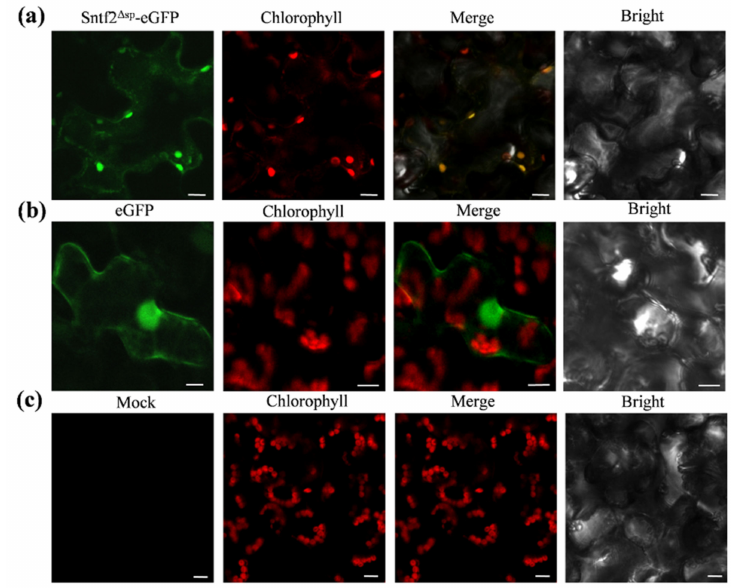
Figure 6. Sntf2 ∆ sp -eGFP was localized to chloroplasts in Nicotiana benthamiana . ( a ) Sntf2 ∆ sp -eGFP fluorescence signal overlapped with the chloroplasts autofluorescence signal. ( b ) The GFP protein was used as a control. ( c ) Mock. Bar: 10 µ